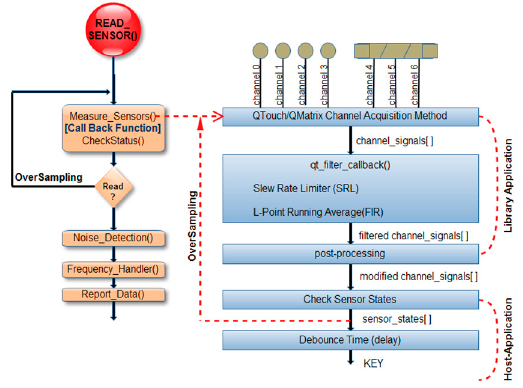
Figure B2. READ_SENSOR function with noise_detection and frequency_handler functions.